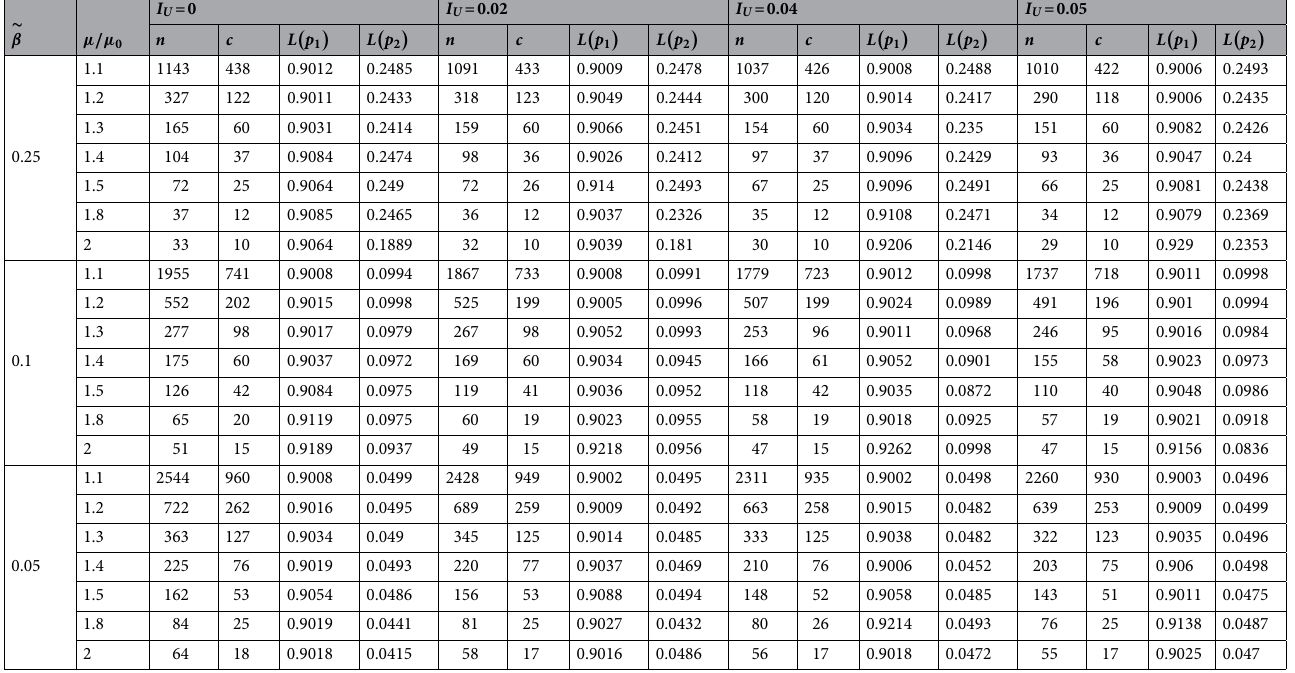
∼ α = 0.10 ; β = 1 and a = 0.50